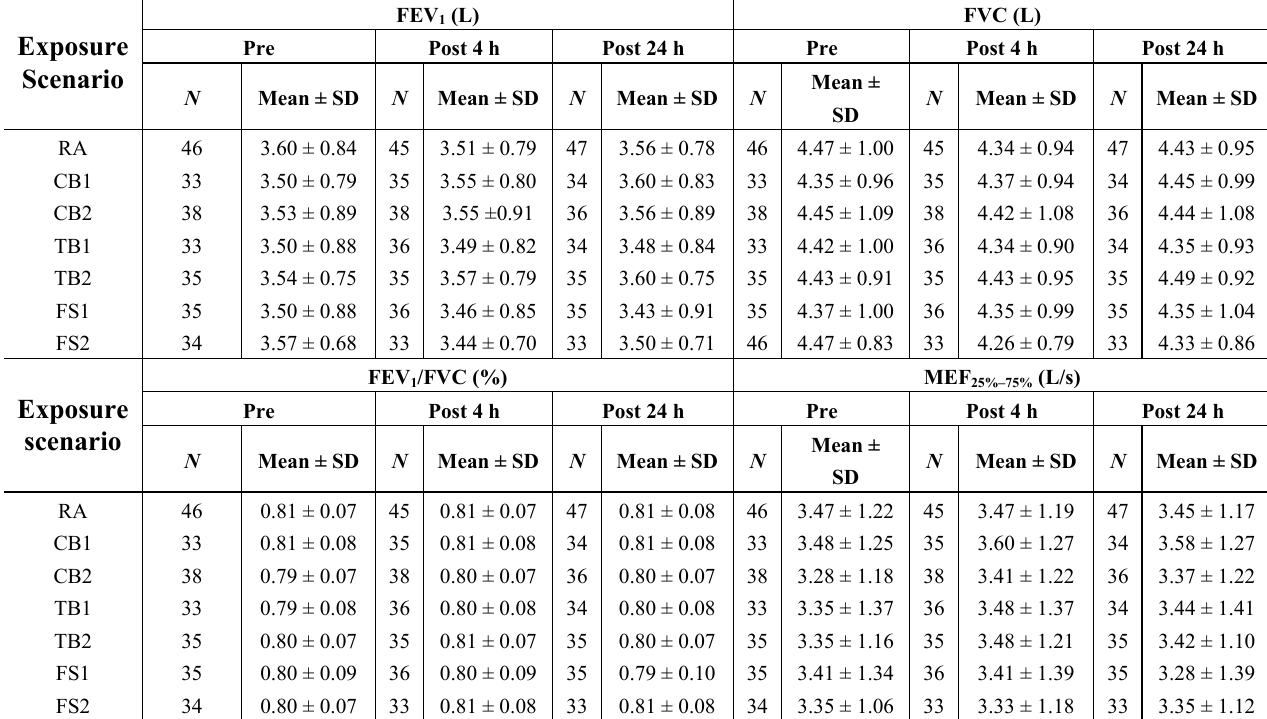
Table 3. Number of measurements (N), mean and standard deviation (SD) of lung function variables before, and 4 h and 24 h after exposure to different indoor sources and exposure levels.